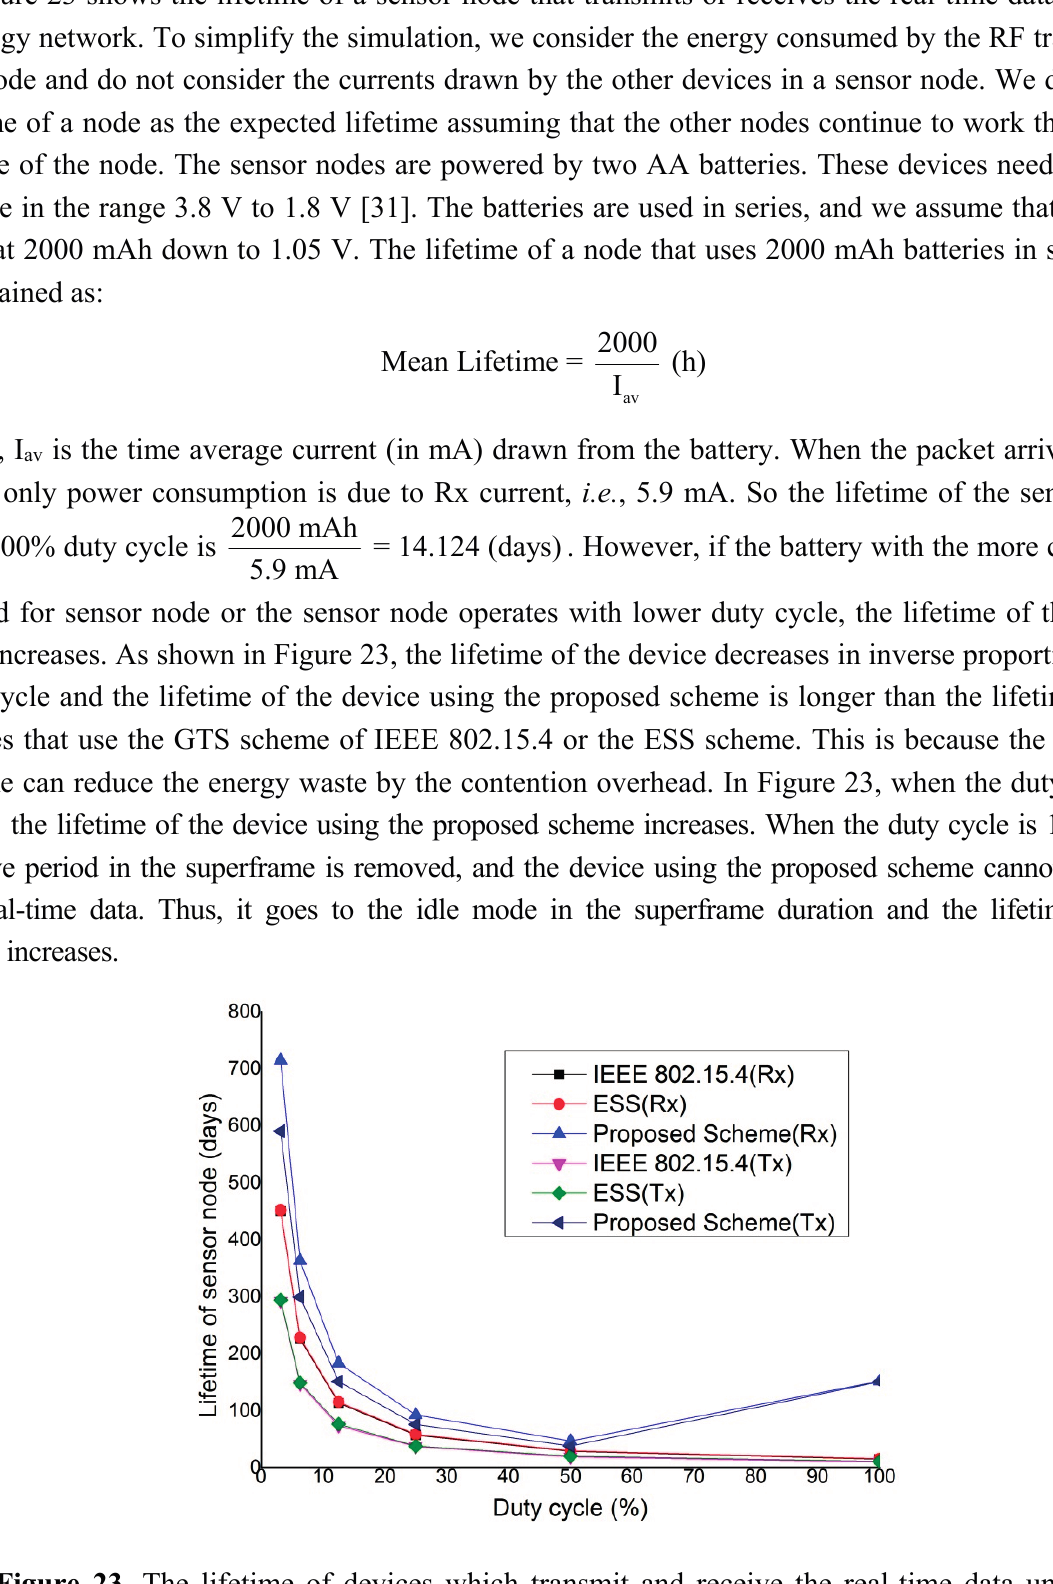
Figure 23. The lifetime of devices which transmit and receive the real-time data under different percentage of duty